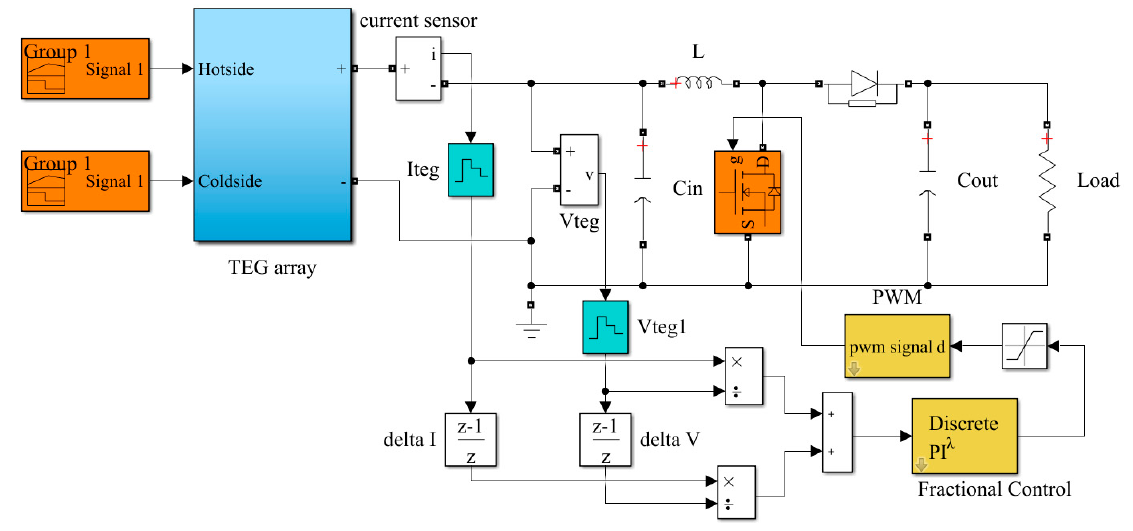
Figure 3. MATLAB model of OFMPPTS.